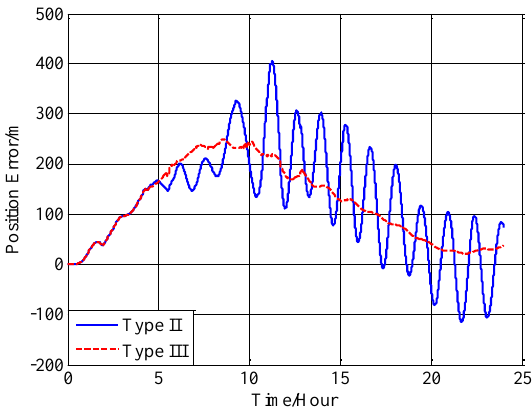
Figure 21. The precision improvement of position with compensation.